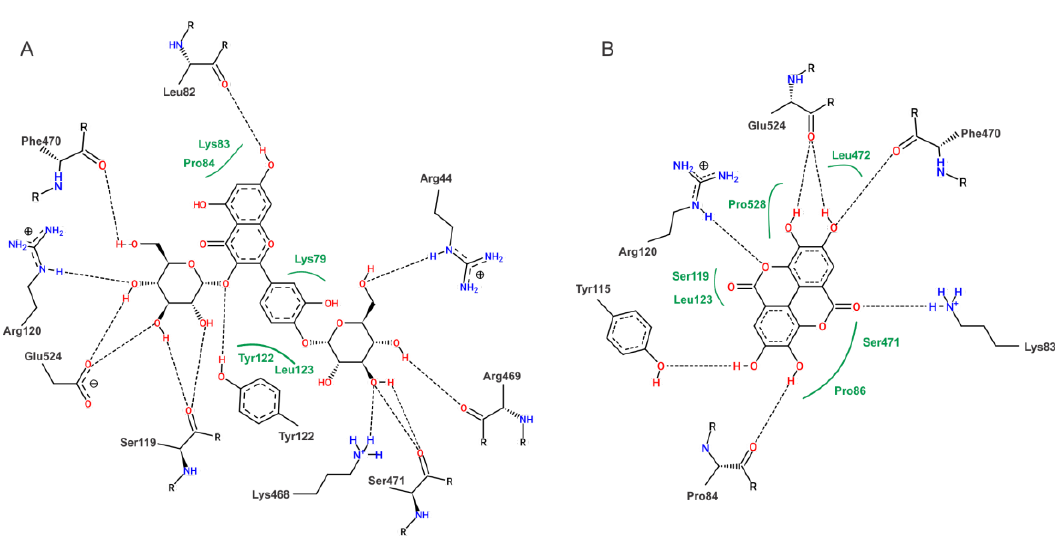
Figure 8. 2D representation of the interactions of COX-2 residues with quercetin 3, 4 ’ -diglucoside ( A ) Figure8. 2DrepresentationoftheinteractionsofCOX-2residueswithquercetin3, 4’-diglucoside( A )and and ellagic acid ( B ). Dashed lines — represent hydrogen bonds; green lines — van der Waals ellagic acid ( B ). Dashed lines—represent hydrogen bonds; green lines—van der Waals interactions. interactions.